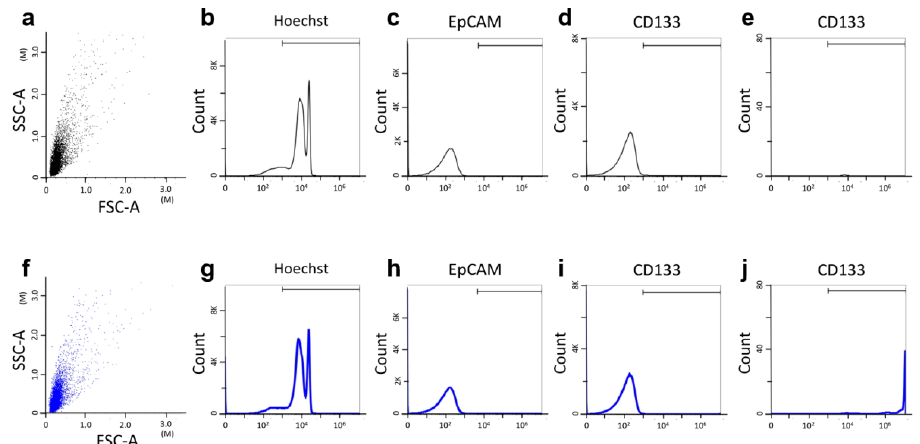
Figure 3. Detecting circulating tumor cells (CTCs) and circulating cancer stem-like cells (cCSCs) using flow cytometry. Panel ( a – e ) shows the isotype control (Hoechst and mouse IgG isotypes for EpCAM and CD133) for CTC and cCSC analysis. Panel ( f – j ) demonstrates real cancer patients’ CTC and cCSC by staining with Hoechst, EpCAM, and CD133 antibodies after red and white blood cells depletion protocol. The gating algorithms are SSC and FSC for whole cell distribution in panel ( a ) and ( f ). Then we gated cells with positive Hoechst expression nucleated cells population in panel ( b ) and ( g ). Based on positive Hoechst situation, EpCAM positive cells were selected and defined as CTCs in panel ( c ) and ( h ). Panel ( d ) and ( i ) shows the gating rationale for CD133 + cells based on positive Hoechst situation. For the definition of cCSCs, CD133-positive cells were gated based on EpCAM + Hoechst + cells as illustrated in panel ( e ) and ( j ). The cell count of CD133 + EpCAM + Hoechst + after negative selection strategy was 17 cells ( e ) and 220 cells ( j ).